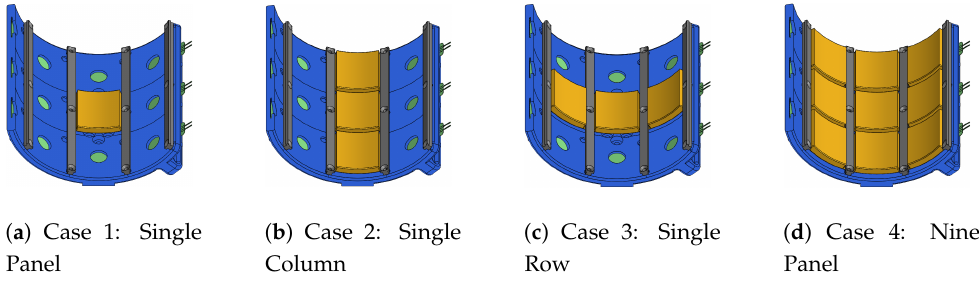
Figure 8. Four different loading cases are used to validate force transmission from panel surfaces to FSRs in the sensorized cuff. Only the panels highlighted for a given case are loaded in that